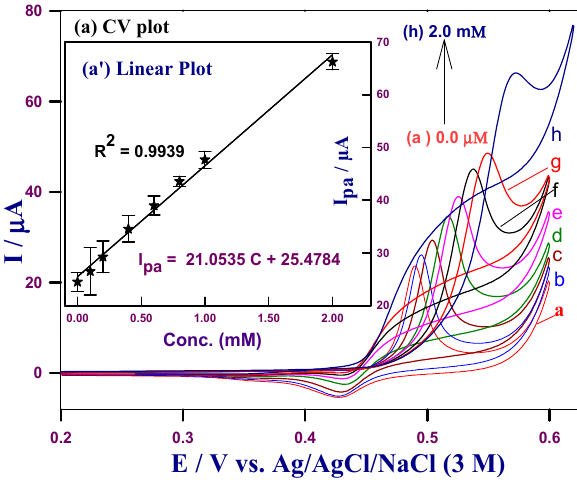
Figure 6. ( a ) CVs of the conditioned HCNiO/GC electrode in 0.05 M NaOH with different concentrations of glucose, (a) 0.0 mM; (b) 0.1 mM; (c) 0.2 mM; (d) 0.4 mM; (e) 0.6 mM; (f) 0.8 mM; (g) 1.0 mM; and (h) 2.0 mM at ν = 50 mV/s; and inset ( a’ ) linearity plot of current vs. concentraion of the CV data. The mean peak current ( n = 3) at the relevant concentration is shown with error bars equal to three standard deviation (3 σ ).